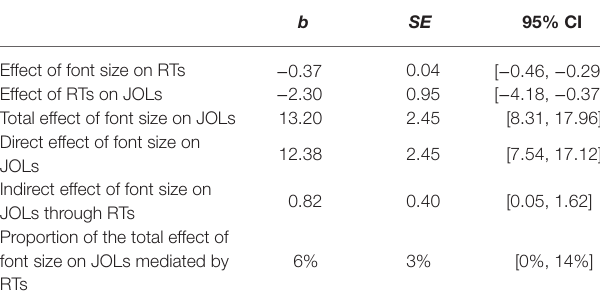
TABLE 2 | Multilevel mediation analysis results in Experiment